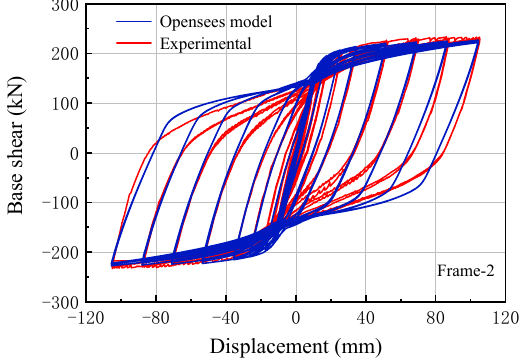
Figure 11. Comparison of test and simulation of Frame ‐ 2.